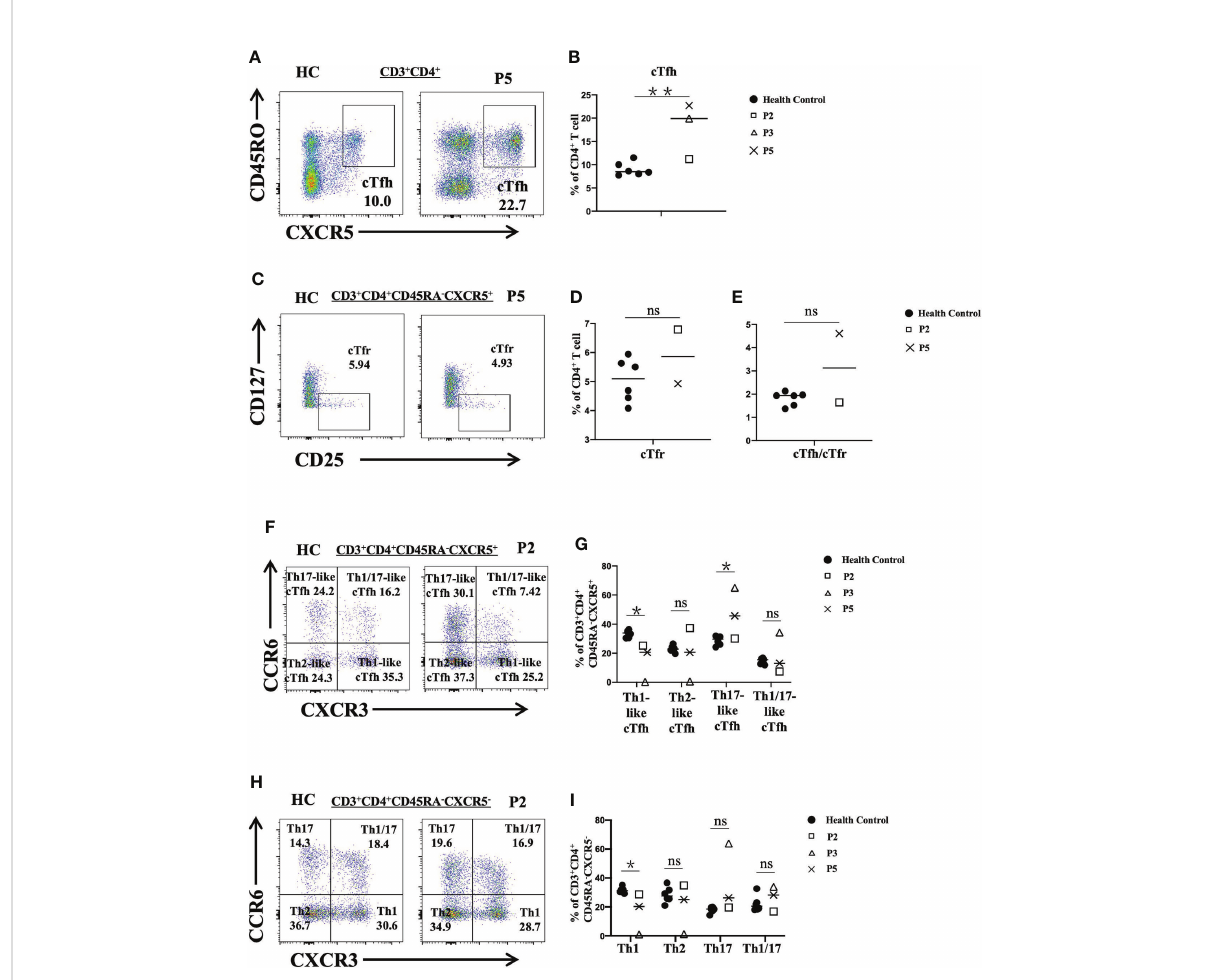
FIGURE 4 Flow cytometric analysis of peripheral CD4 + T-cell subsets in patients with FOXP3 de fi ciency. (A) and (B) The percentage of cTfh cells (CD3 + CD4 + CD45RA - CXCR5 + ) among CD4 + T cells. (C) and (D) The frequency of cTfr cells (CD3 + CD4 + CD127 - CD25 + ) among CD4 + T cells. (E) The ratio of cTfh cells to cTfr cells. (F) and (G) The percentages of cTfh-cell subsets: Th1-like cTfh cells (CXCR3 + CCR6 - ), Th2-like cTfh cells (CXCR3 - CCR6 - ), and Th17-like cTfh cells (CXCR3 - CCR6 + ). (H) and (I) The frequency of CD4 + T-cell (CD3 + CD4 + CD45RA - CXCR5 - ) subsets: Th1 cells (CXCR3 + CCR6 - ), Th2 cells (CXCR3 - CCR6 - ), and Th17 cells (CXCR3 - CCR6 + ). *P<0.05; **P<0.01; ns, no signi fi